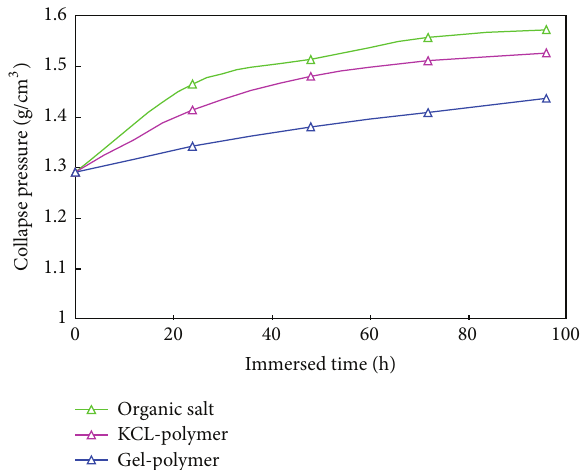
Figure 5: Time-dependent collapse pressure of Nahr Umr Shale.